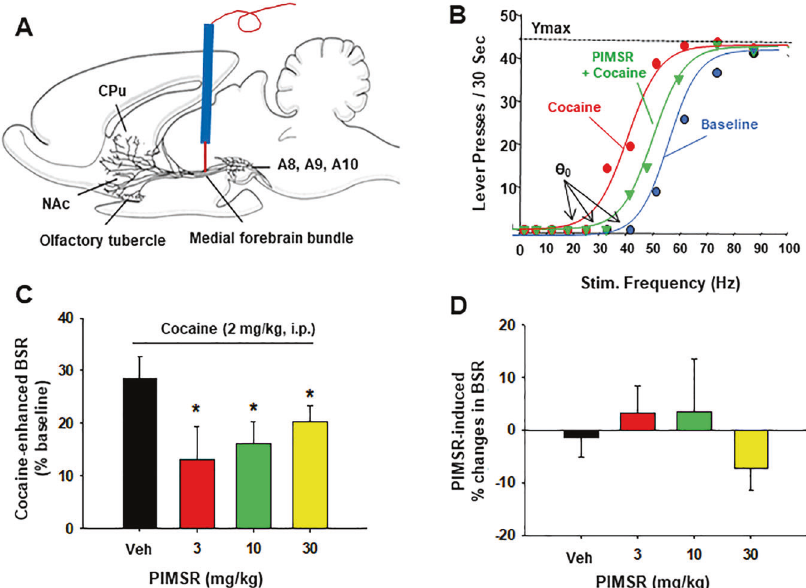
Fig. 5 The effects of PIMSR on electrical ICSS in rats. A A schematic diagram showing the experimental methods. B Representative stimulation-response curves, illustrating the stimulation threshold ( θ 0 ), Y max , and the effects of cocaine and/or PIMSR on the stimulation- response curve. Cocaine (2 mg/kg, i.p.) shifted the stimulation-response curve to the left and decreased the stimulation threshold ( θ 0 value), which was ameliorated by PIMSR. C Cocaine-induced reduction in the θ 0 value (% baseline) in the absence or presence of PIMSR, indicating that cocaine alone produced an enhancement in ICSS (as less stimulation current was required to initiate ICSS in the presence of cocaine). This effect was attenuated by pretreatment with PIMSR. D PIMSR alone ( n = 12) did not alter the θ 0 value, suggesting that it is not rewarding or aversive by itself. * p < 0.05, compared to